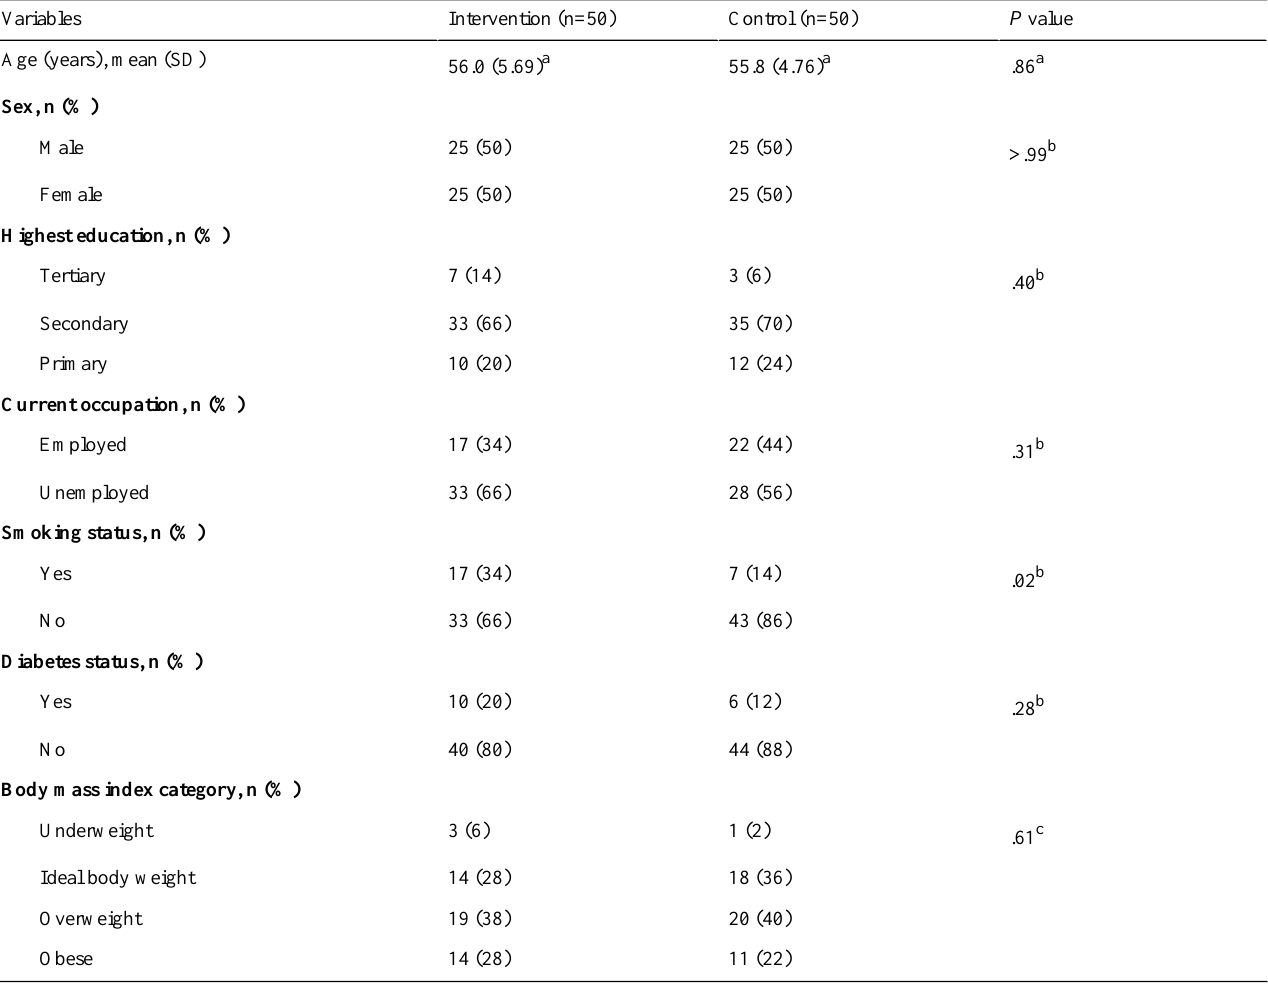
Table 1. Sociodemographic and health characteristics of participants by intervention and control group